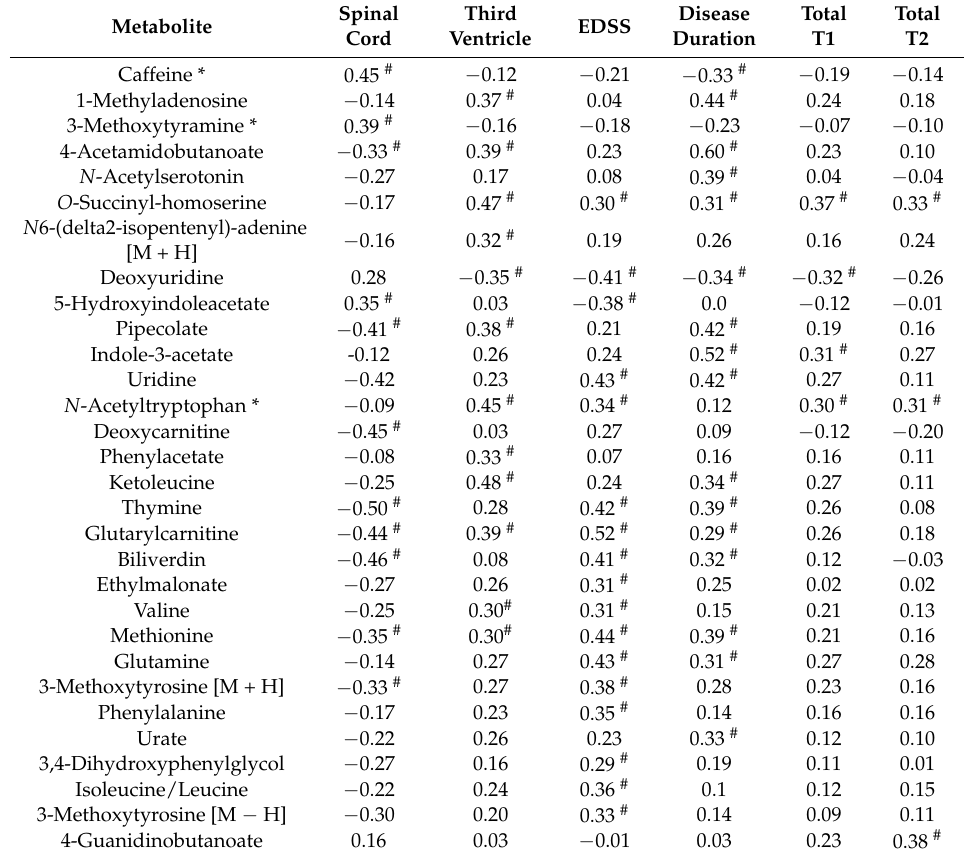
Table 6. Association analysis between altered metabolites and clinical data: radiological data, the expanded disability score scale (EDSS) and disease duration. Only metabolites that depicted a significant association with at least one measure have been